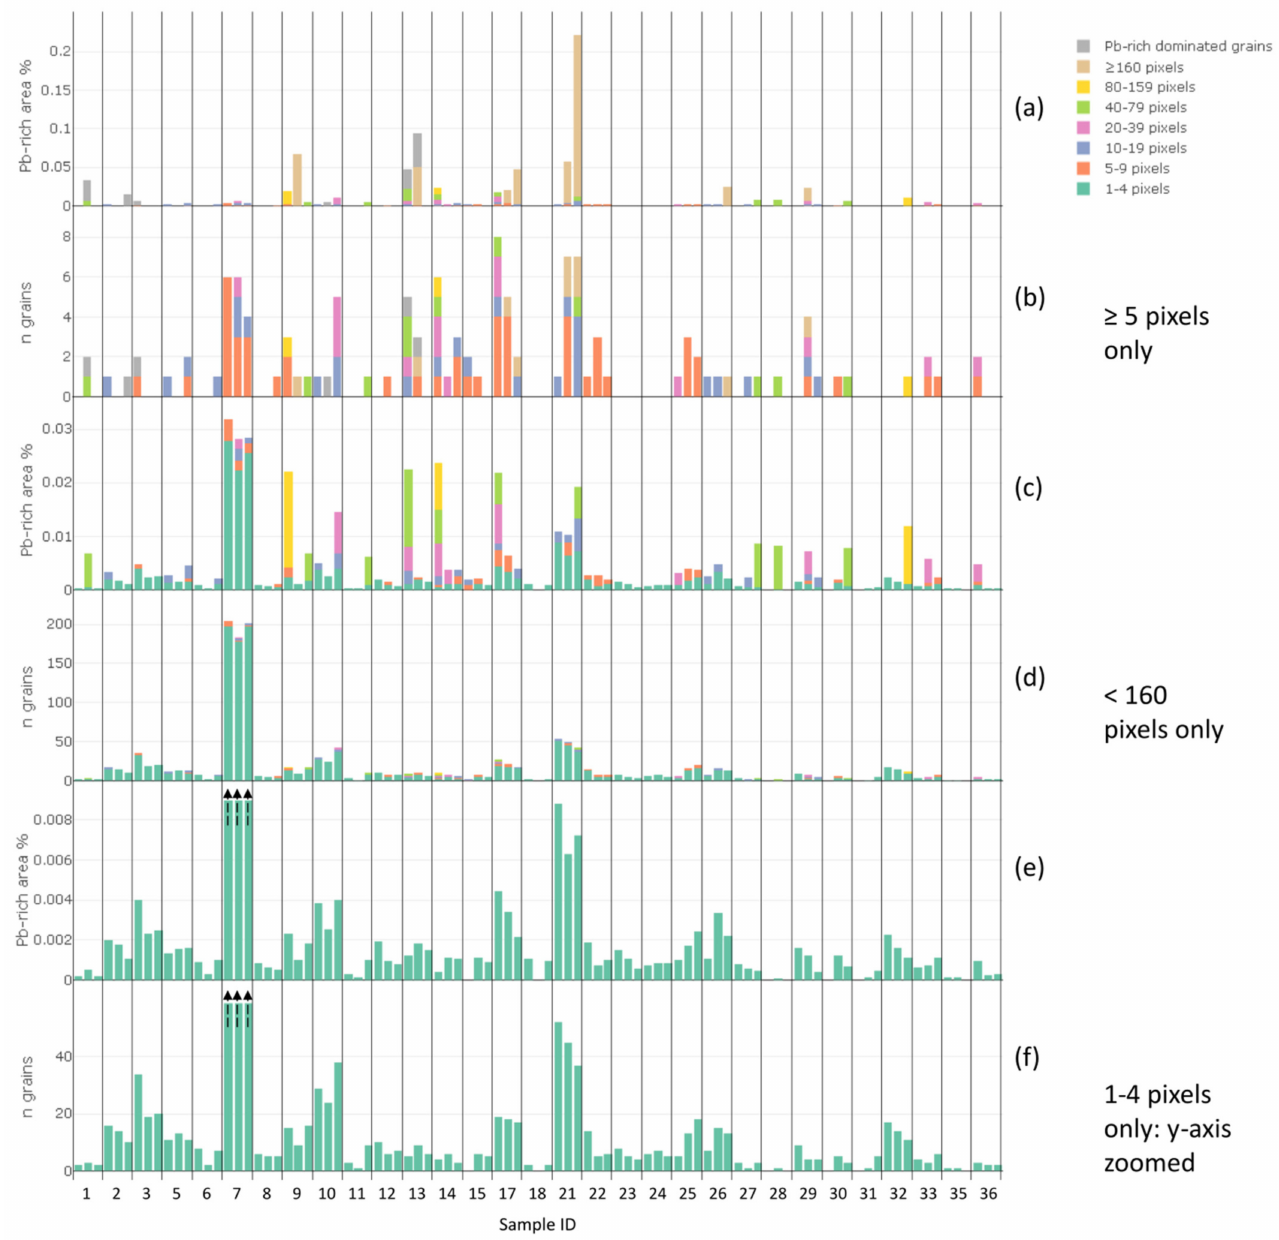
Figure 11. Filtered versions of results shown in Figure 10, showing here Pb-rich contributions from: ( a , b ), grains bearing ≥ 5 Pb-rich pixels; ( c , d ), grains bearing < 160 pixels; ( e , f ), grains bearing 1–4 pixels Pb-rich, with y-axis zoomed to the range of the dataset excluding sample 7 (where the relevant values can be read directly from ( c , d )). Black dashed arrows in ( e , f ) indicate the bars that are truncated due to the zoomed y -axis